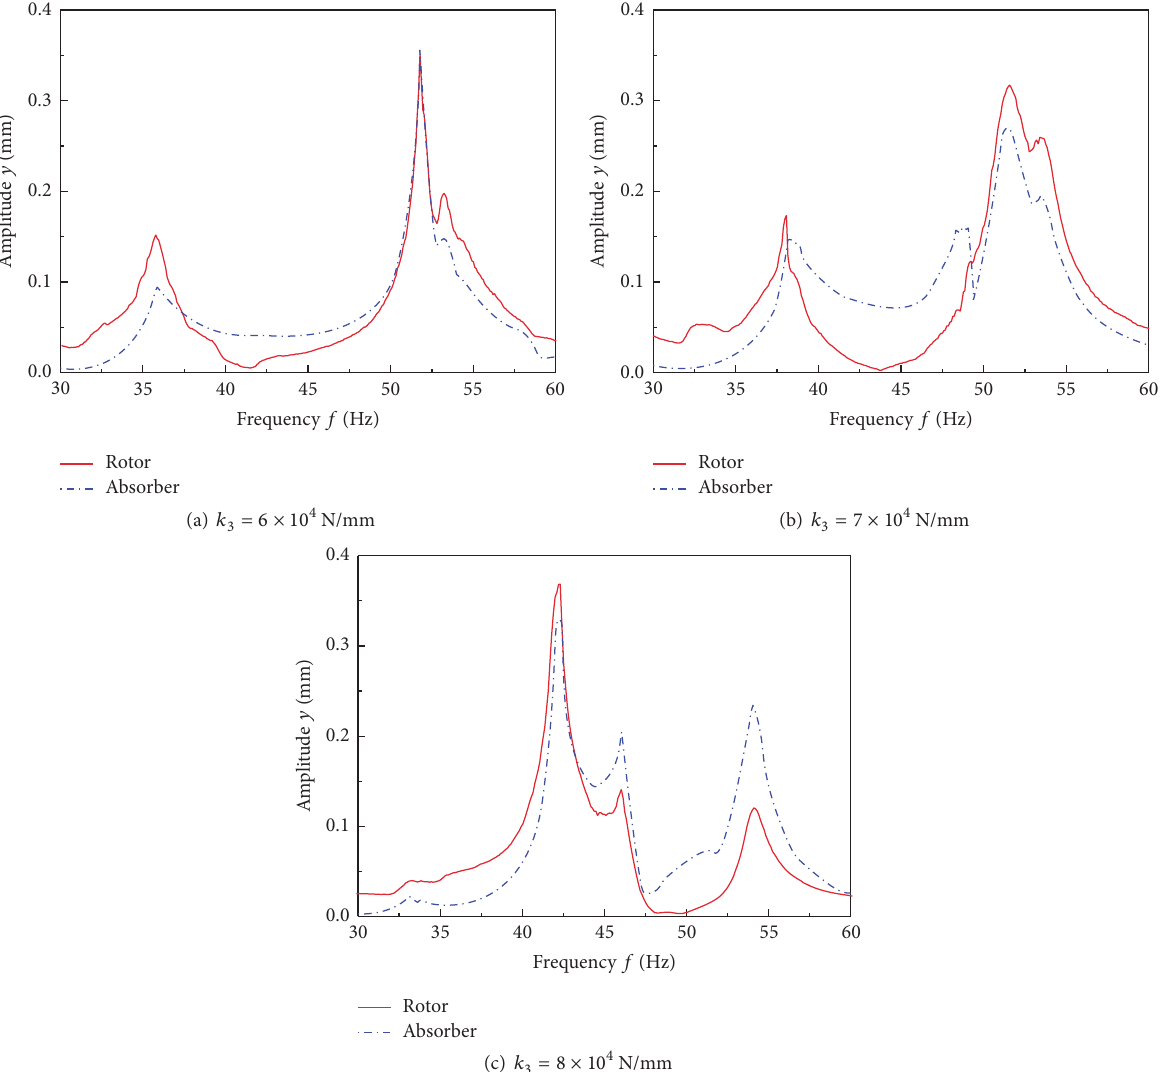
Figure 14: Responses of the rotor-absorber system with different 𝑘 3 when ℎ is